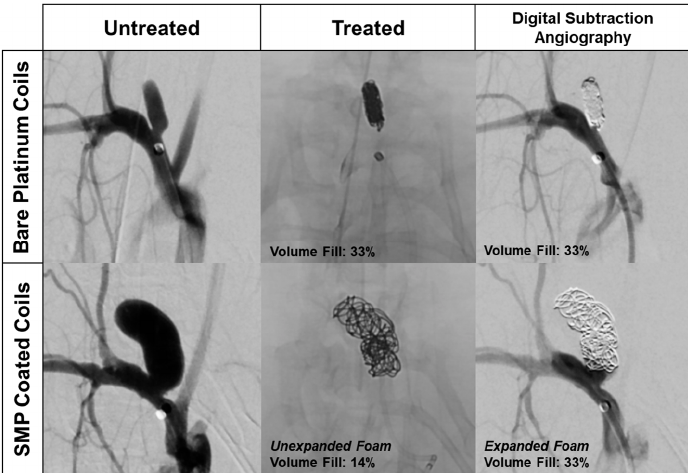
Figure 1. Rabbit elastase aneurysm treated with ( Top Row ) bare platinum coils (BPCs) and ( Bottom Row ) shape memory polymer (SMP) foam coated coils. Middle Column—BPCs have a more dense 2D radiographic projection during device delivery. Right Column—Calculated volumetric occlusion for both aneurysms is the same.